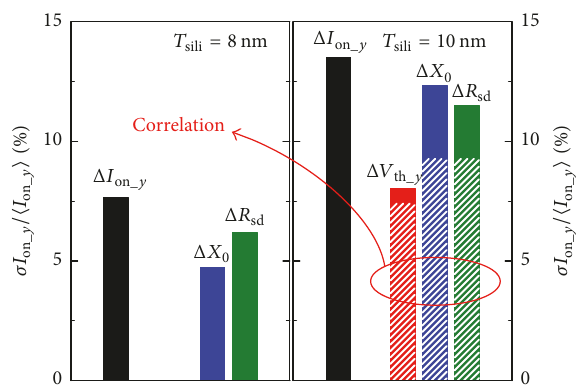
Figure 6: 𝐼 variations and variations of the dc parameters ( 𝑉 on 𝑦 𝑋 𝑅 ) contributing to the 𝐼 0 , and sd 10nm.